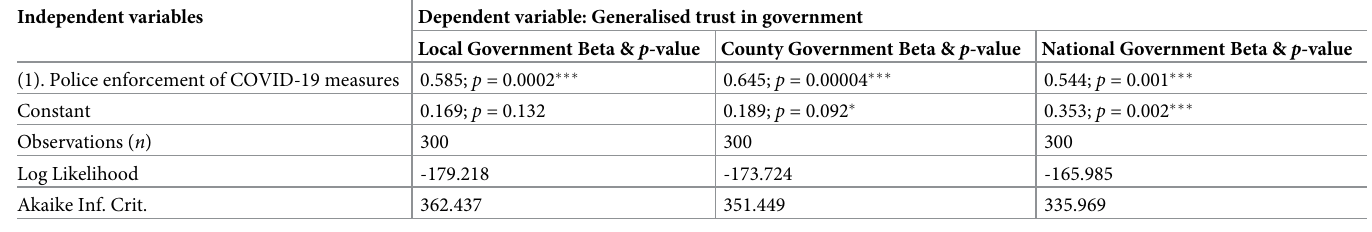
Table 7. Perception of police enforcement of COVID-19 measures among self-confirmed CHVs (Probit model). Independent